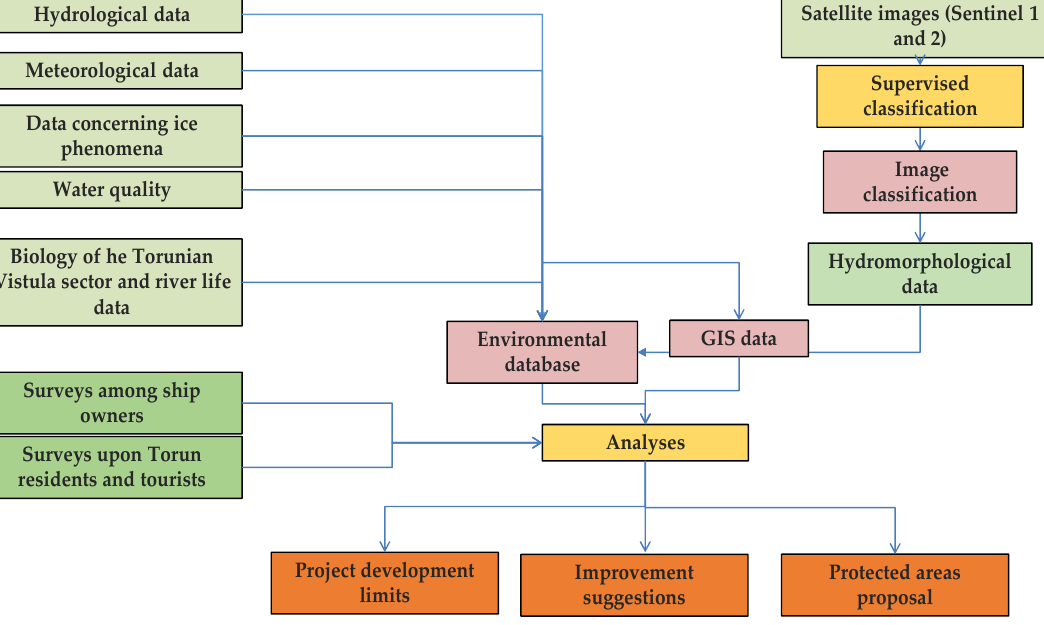
Figure 5. The flowchart of the research